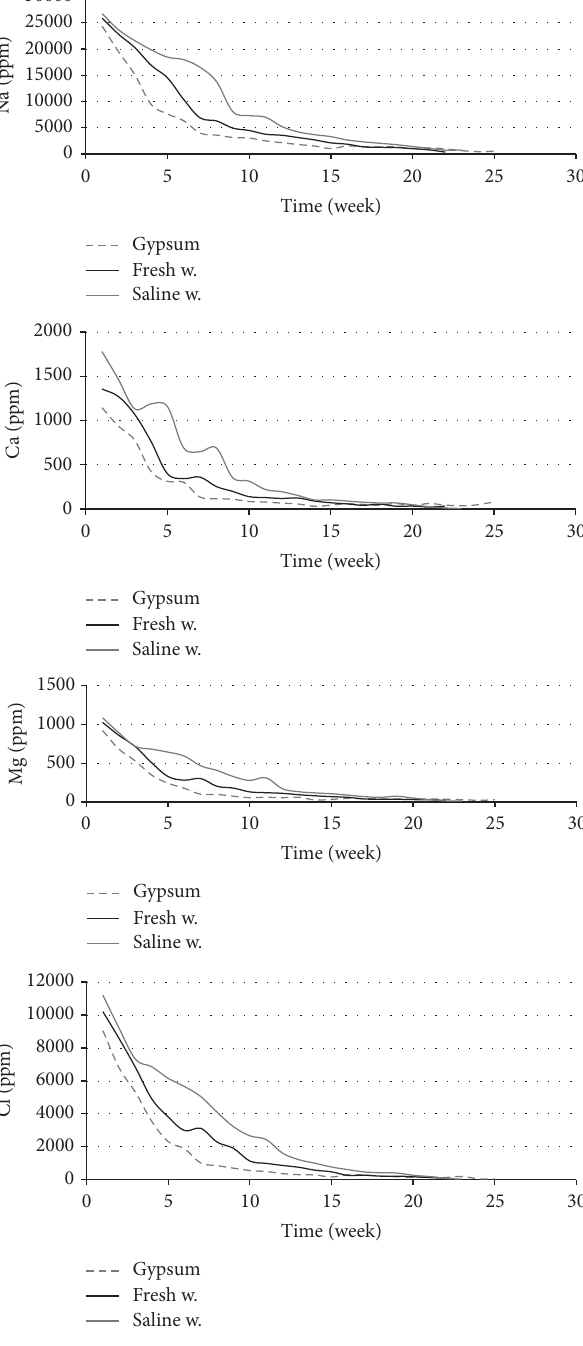
Figure 4: Decline in ionic composition (Na + , Ca +2 , Mg +2 , and Cl − ) of drainage water for all treatments.